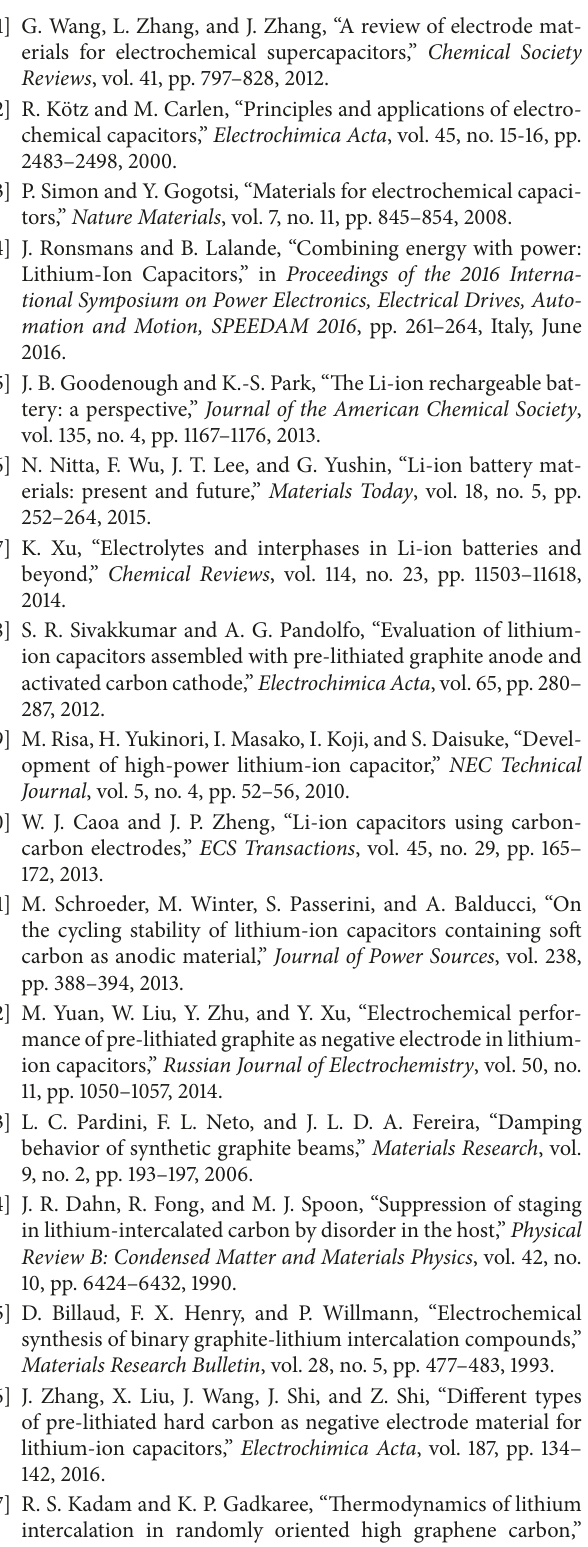
Figure 12: Comparison of irreversible capacities at 100 C rate.